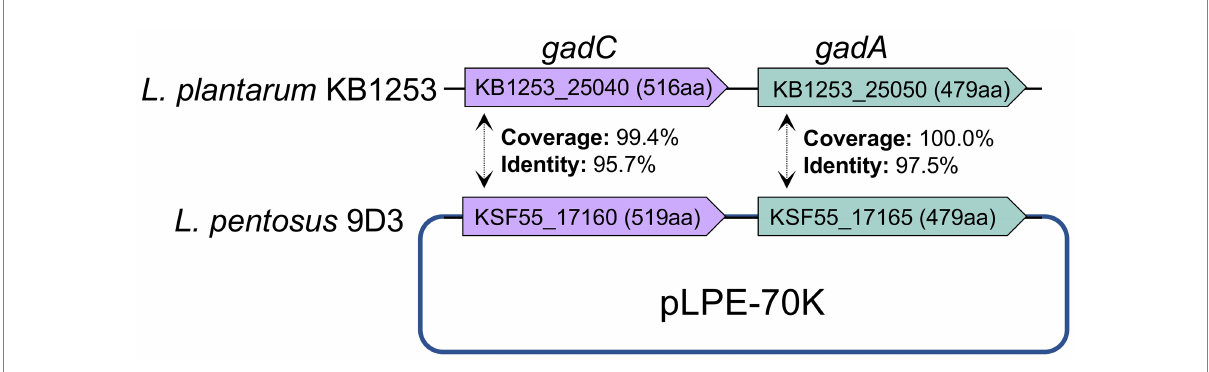
FIGURE 6 Comparison of genes related to GABA production of L. pentosus 9D3 and L. plantarum KB1253, a GABA-producing reference strain. gadA , glutamate decarboxylase; gadC , glutamate-GABA